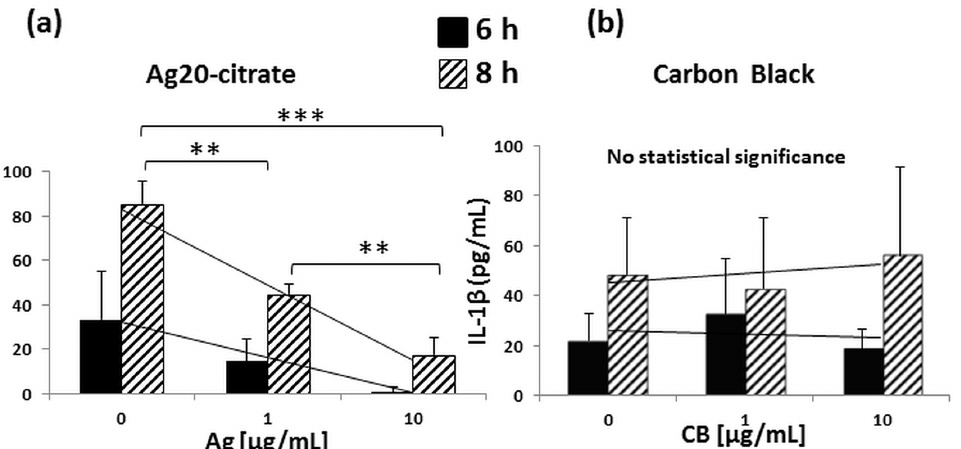
Fig 5. Effect of AgNP and CB on IL-1 β production. After differentiation for 7 days, MDM were harvested, counted, and plated at concentrations of 0.7 – 1 x 10 5 cells per well into 96-well plates. The next day, MDM were incubated with 0, 1 and 10 μ g/mL of Ag20-citrate (a) or CB (b) in the presence of M . tb at MOI 10 at 37°C and 5% CO 2 in a humidified environment. MDM cultured in complete media served as negative control. Culture supernatants were collected at 6 and 8 hours and analyzed by IL-1 β ELISA as described in Materials and Methods. Each data point (Y-axis) represents pg/mL of IL-1 β ± SD from three independent experiments. Statistically significant changes relative to M . tb -exposed MDM (0 on X-axes) were determined by two-tailed unpaired t-test and marked by ** ( p < 0.01) or *** ( p <